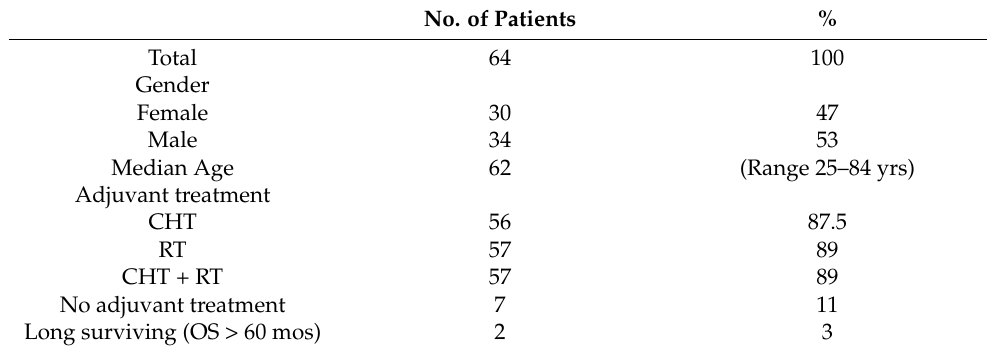
Table 1. Study population.